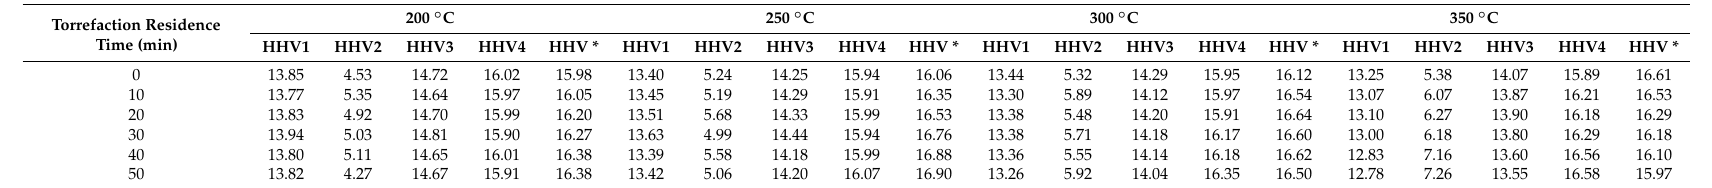
Table 3. Validating the predicted higher heating value (HHV) with the experimental